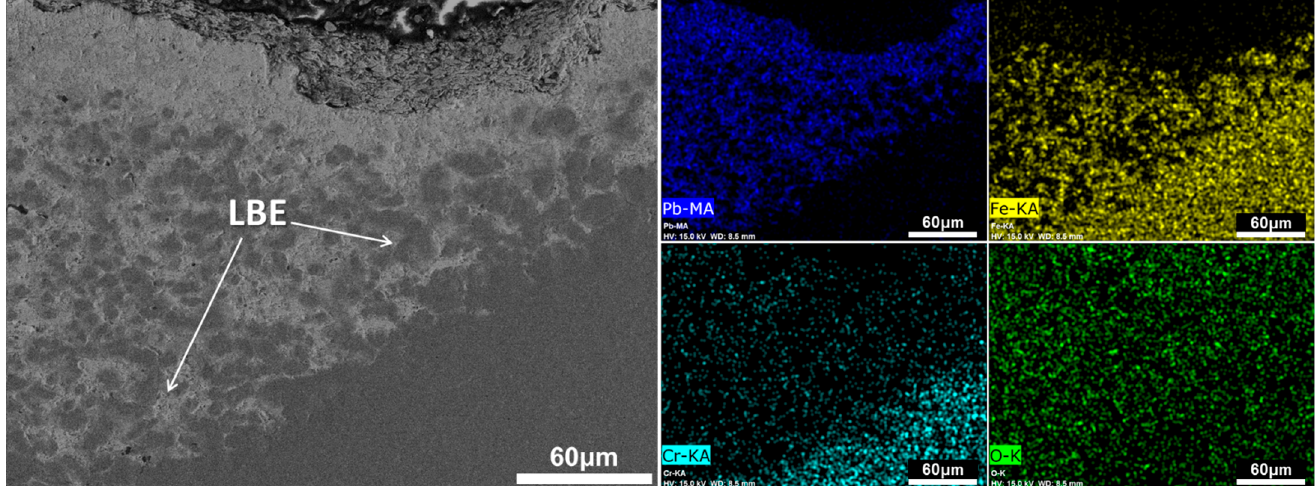
Figure 10. EDS analysis of the LBE-penetrated regions on HT9 for Cr-depleted and inner Cr-rich reformed oxide regions after 2000 h at 600 °C.